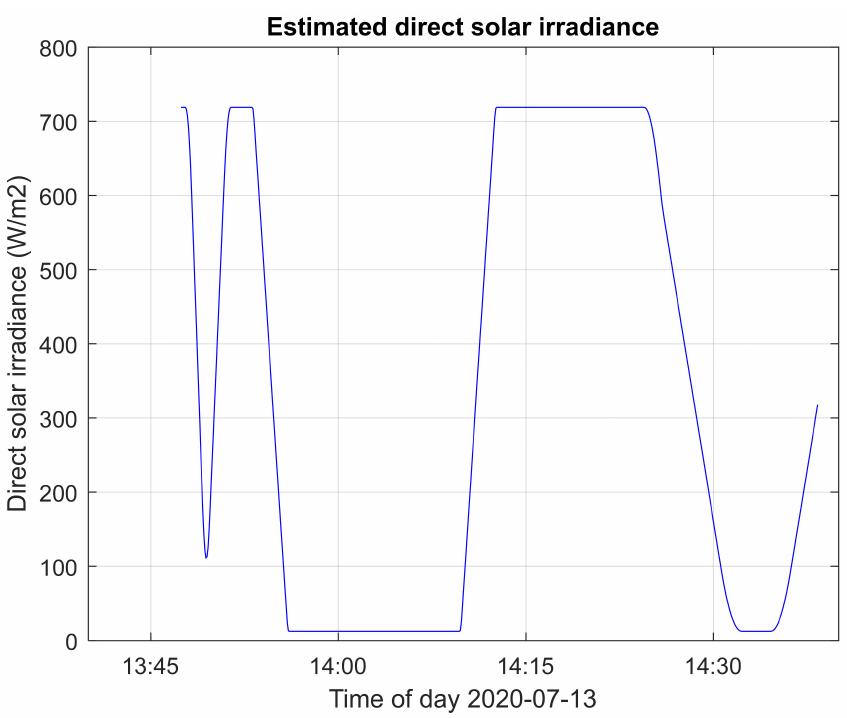
Figure 20. Predicted level of direct solar irradiance on 13 July 2020 from 13:45 until 14:40.